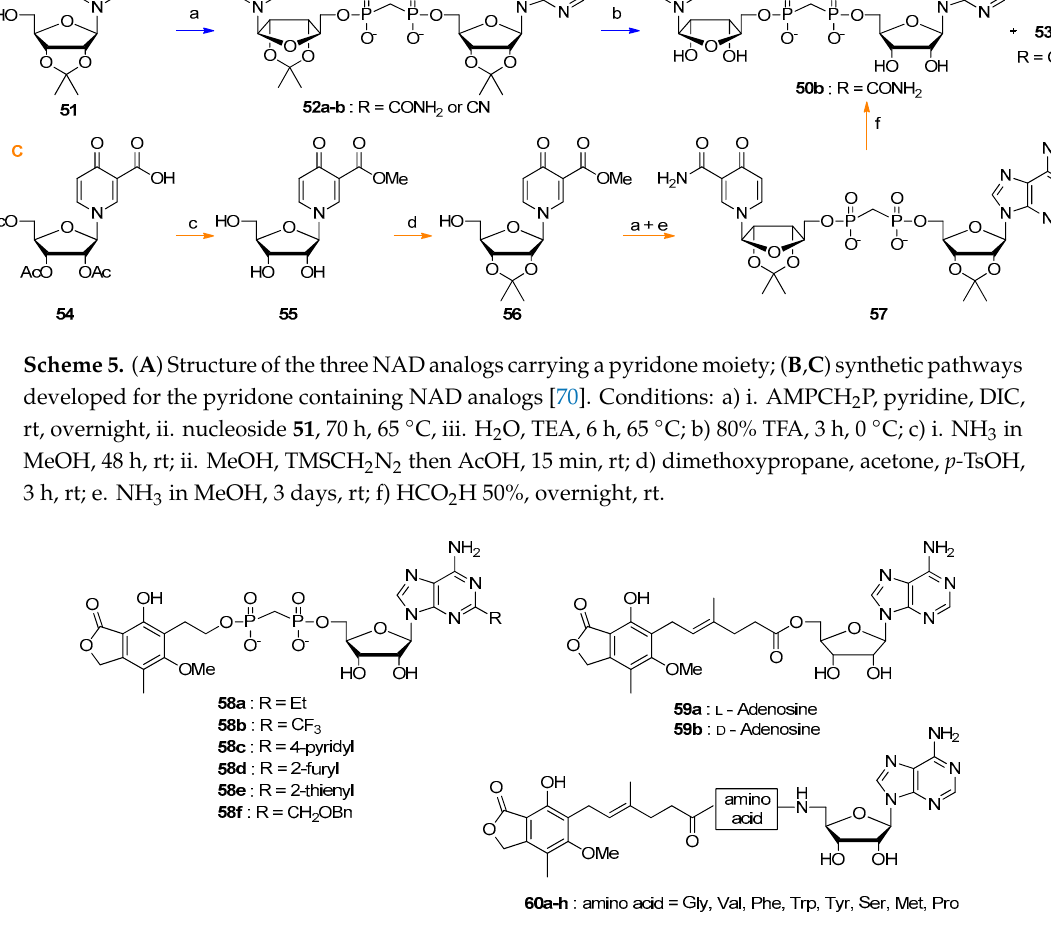
Figure 12. Three classes of MPA containing NAD analogs synthesized by Felczak et al. [72].